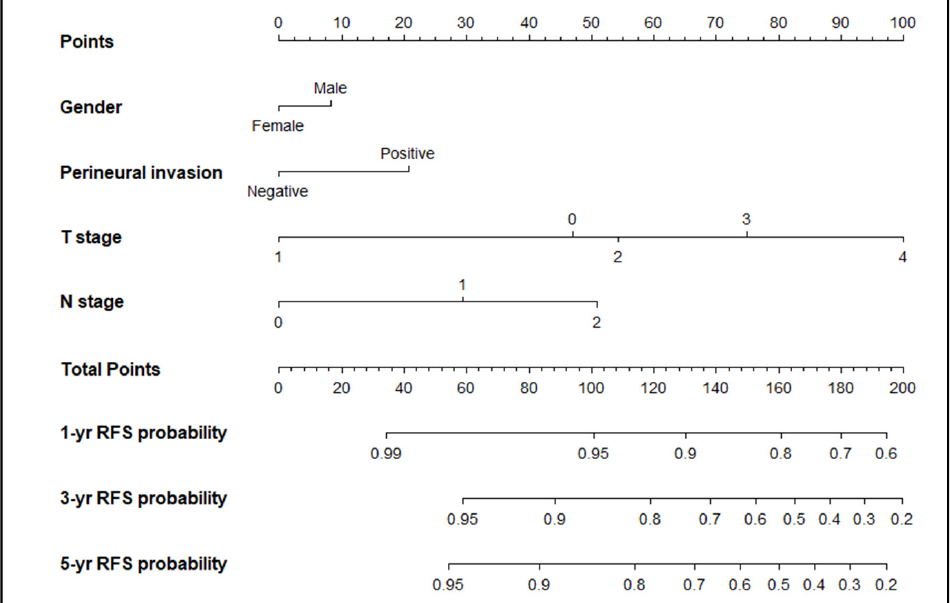
Figure 2. Nomogram predicting the probability of recurrence after radical surgery for colorectal cancer. According to the prediction model, oncologic outcomes were compared by dividing the study population into the high-recurrence risk (HR) and low-recurrence risk (LR) groups. RFS was longer in the LI group with LR patients (55.66 ± 21.15 vs. 53.08 ± 23.76 (45.48 ± 27.57 vs. 46.91 ± 25.45 months, p = 0.352) (Figure 3A). PRS was shorter in the LI